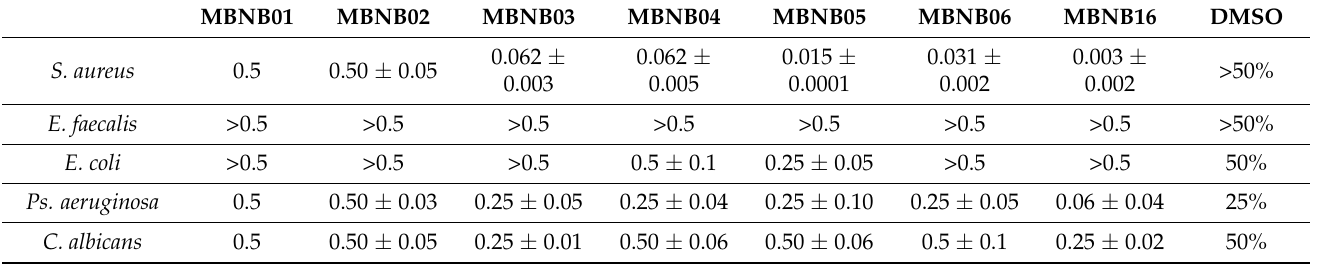
Table 3. Minimal Biofilm Inhibitory Concentration (MBIC) of the samples expressed in mg/mL for the different microbial strains. Data are reported as mean ± SD.